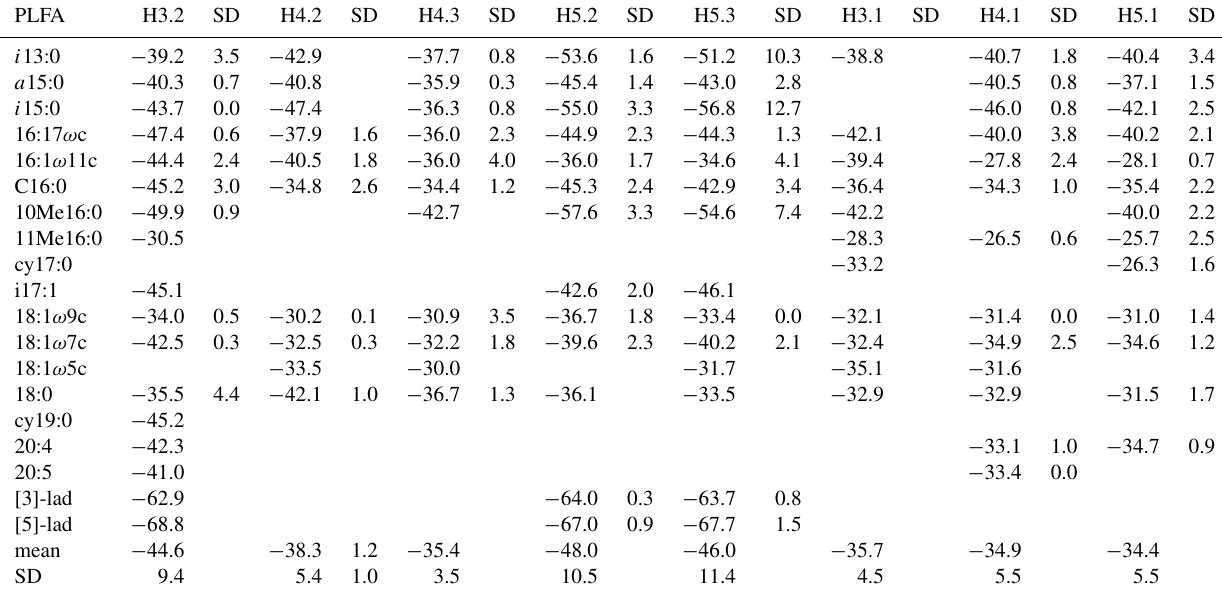
Table 4. PLFA δ 13 C values averaged for the sampled month in the different wells. PLFA